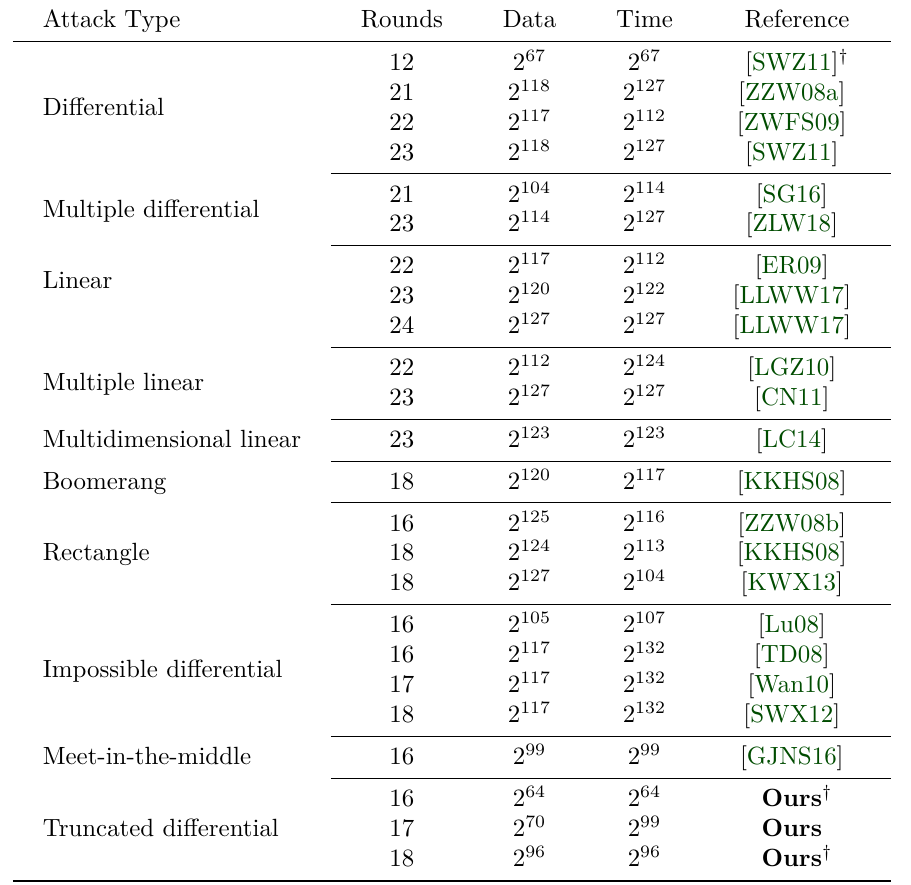
Table 1: An overview of attacks on the SM4 block cipher. Attacks marked by † are distinguishers, the others are key-recovery